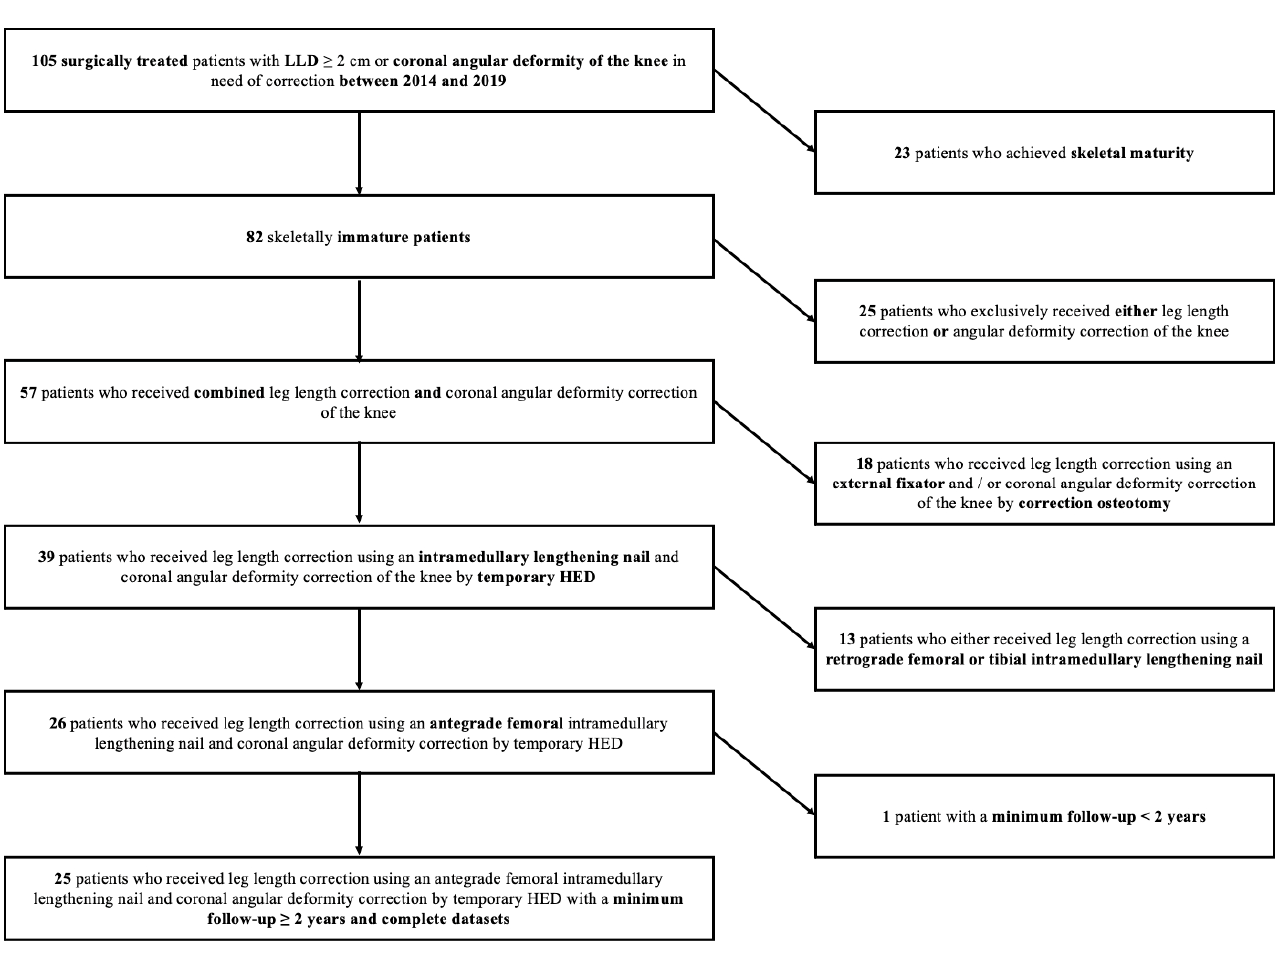
Figure 1. Strengthening the Reporting of Observational studies in Epidemiology (STROBE) diagram detailing the inclusion and exclusion criteria for the study cohort. LLD: Leg length discrepancy. HED: Hemiepiphysiodesis.